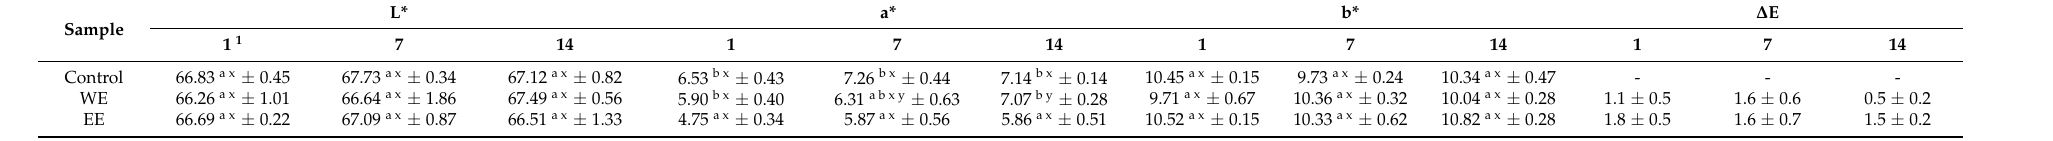
Table 3. Evolution of colour parameters (L*a*b*) of chicken meatballs during refrigerated storage.